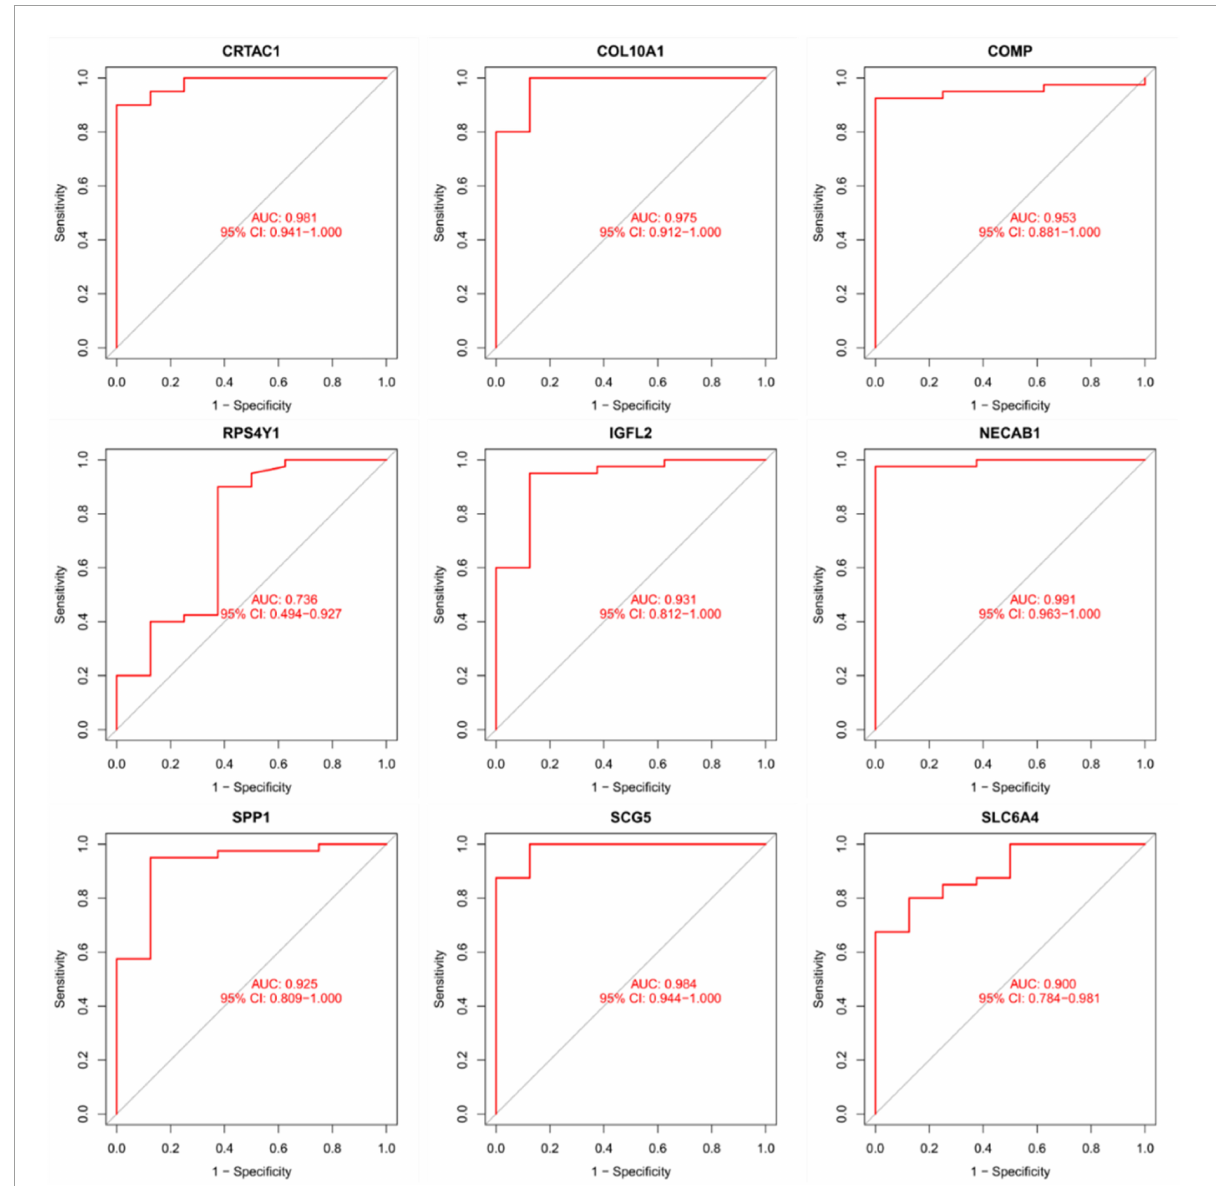
FIGURE11 The receiver operating characteristic (ROC) curve of the diagnostic effectiveness of the nine diagnostic markers in the GSE53845 dataset.